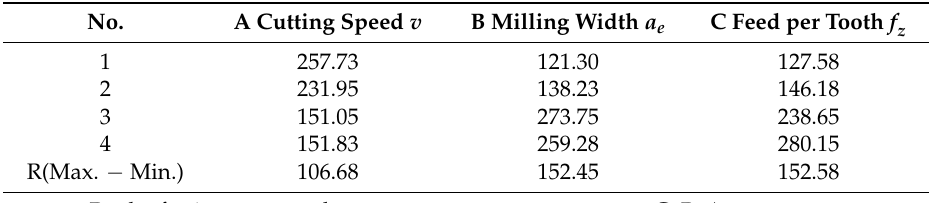
Table 6. Range table of F x (N).